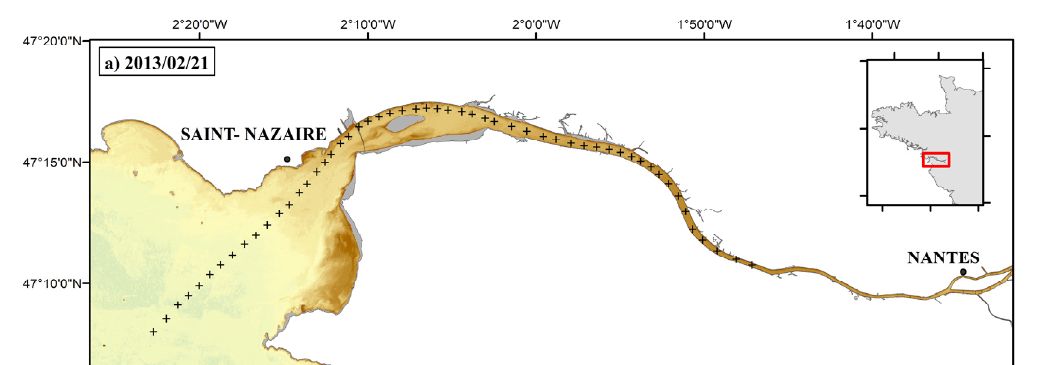
Figure 5. ( a ) SPOT4 suspended particulate matter (SPM) concentration in the Gironde estuary on 20 February 2013; ( b ) SPOT4 SPM concentration on 5 June 2013; ( c ) Landsat8 SPM concentration on 10 July 2013; ( d ) Landsat8 SPM concentration on 30 October 2013. The crosses show the location of the transect pixels used in Figure